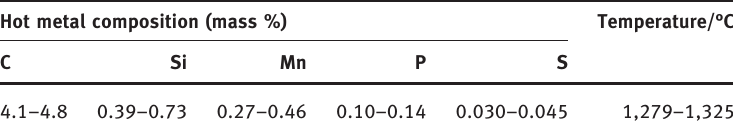
Table 1: Composition and temperature of the hot metal in the present study. Hot metal composition (mass %)